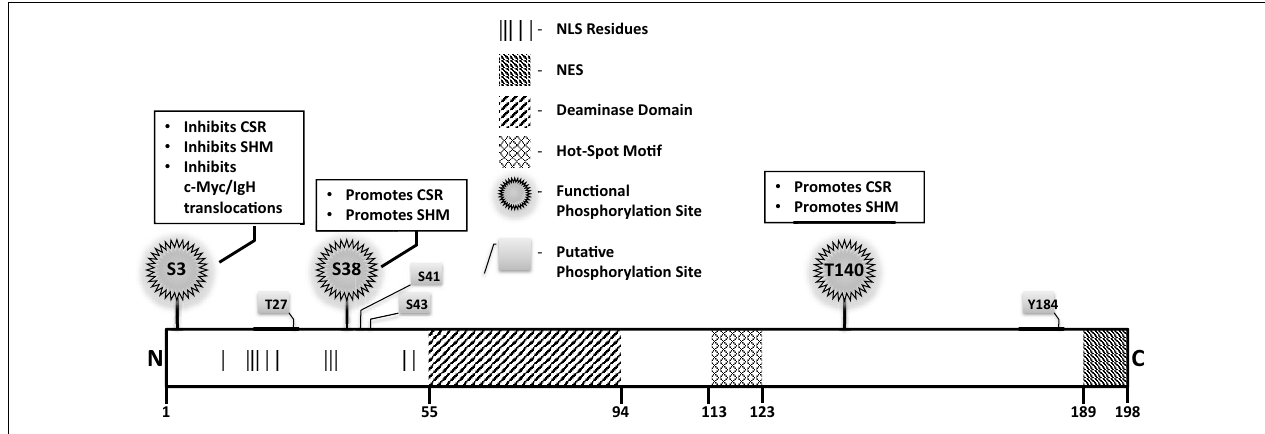
FIGURE 4 | NotableAID domains and residues . Primary structure of AID protein with pertinent domains, motifs, and residues indicated. Panels outlined in black briefly describe functional impact of validated phosphorylation